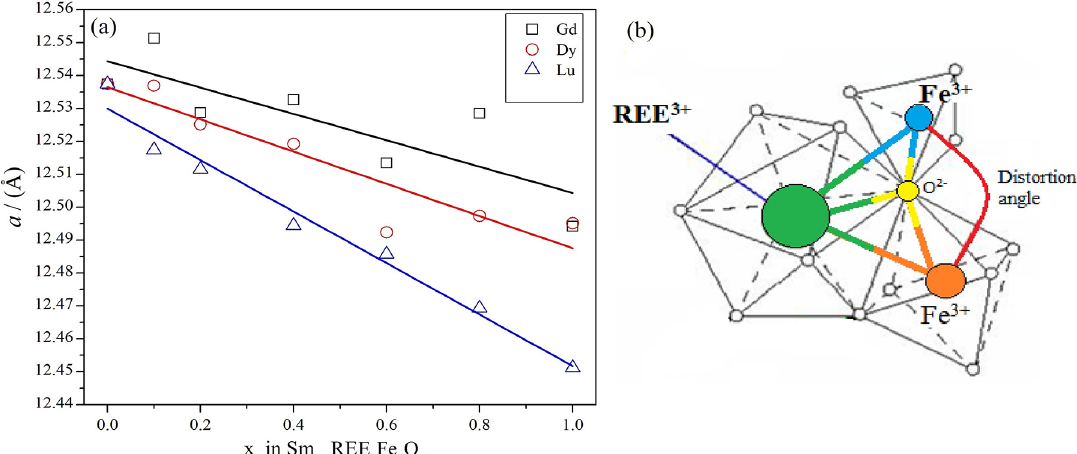
REE Fe O (REE= Gd, Dy y Lu) and (b) distortion angle experienced 3-x x 5 12